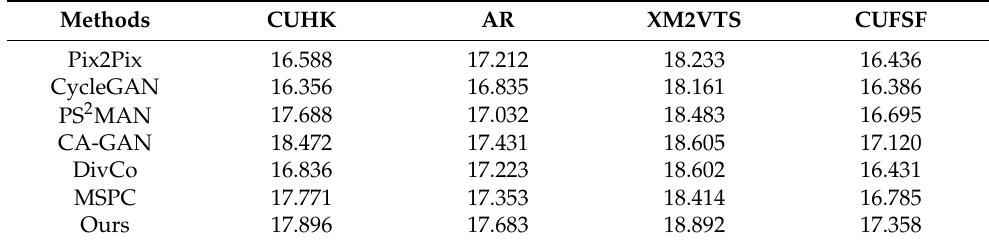
Table 3. PSNR comparison of photos synthesized by different models on the data.